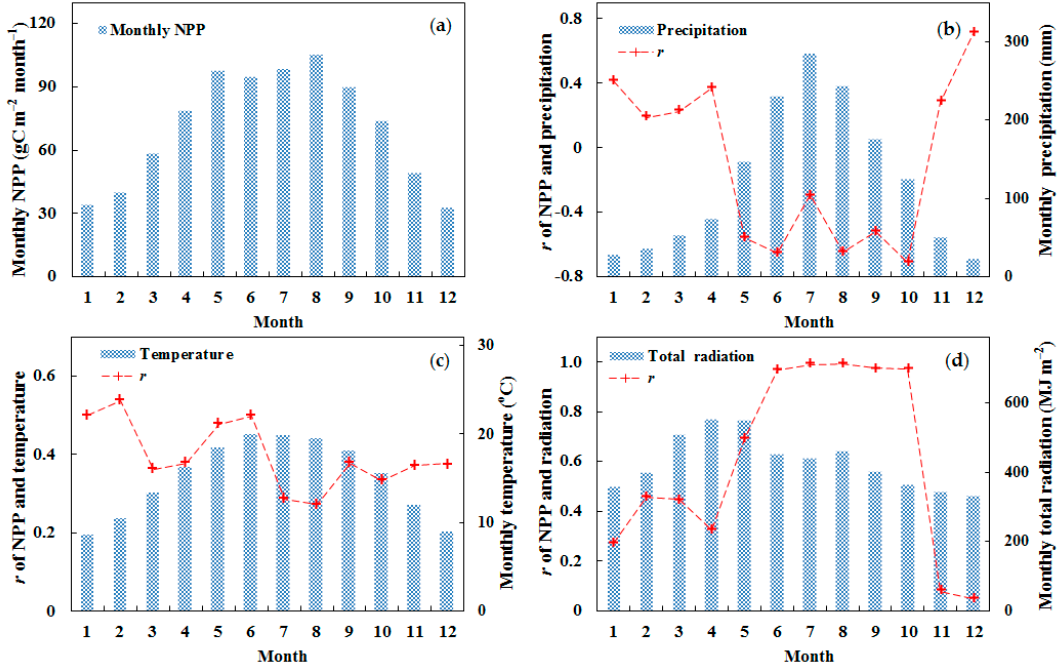
Figure 9. The intra-annual variation of: ( a ) monthly NPP; ( b ) monthly precipitation and its correlation with NPP; ( c ) monthly temperature and its correlation with NPP; and ( d ) monthly total solar radiation and its correlation with NPP. The histogram is the averaging amount of NPP or climatic factors for all the 33 years in a given month, and the red dashed line is the correlation coefficient for the annual variation of NPP and climatic factors in a given month.